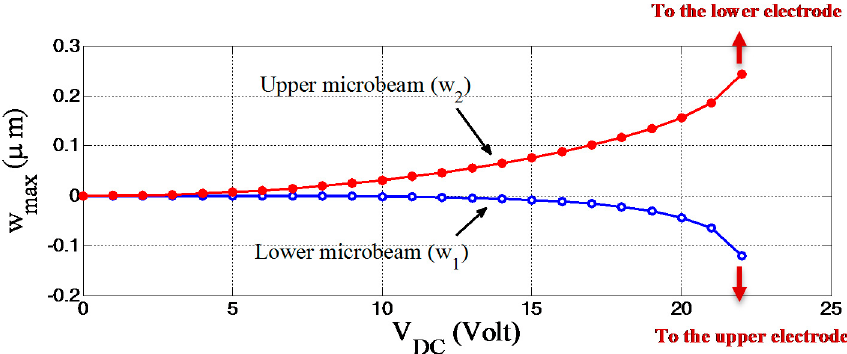
Figure 3. Variation of the maximum static deflection with the DC voltage for the lower and upper microbeams and for the case when d 1 = d 2 .